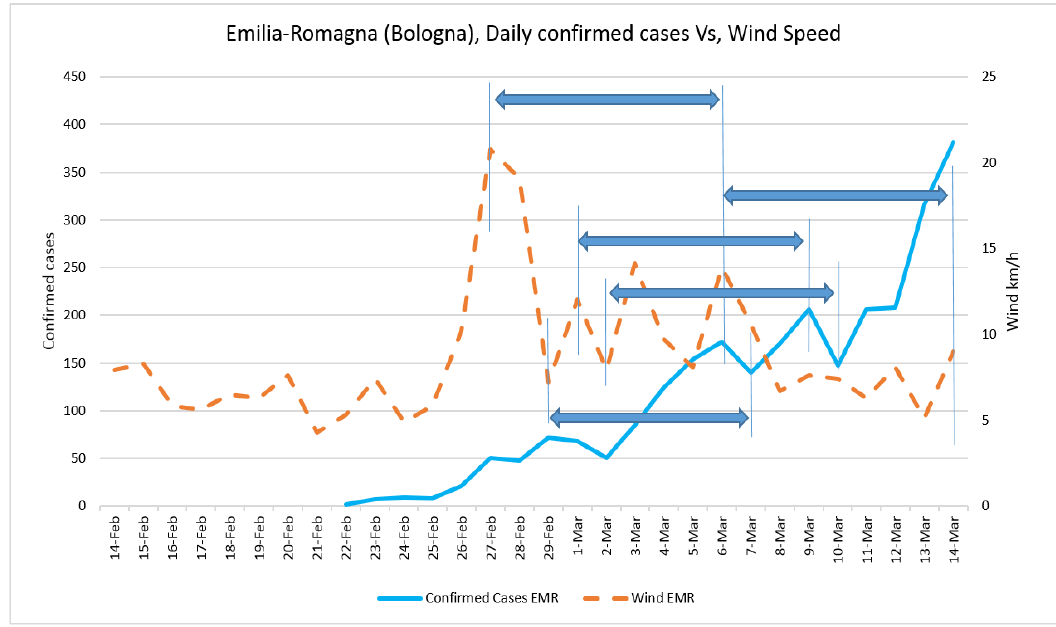
Figure 9. Daily confirmed cases of COVID-19 in Emilia-Romagna and wind speed.